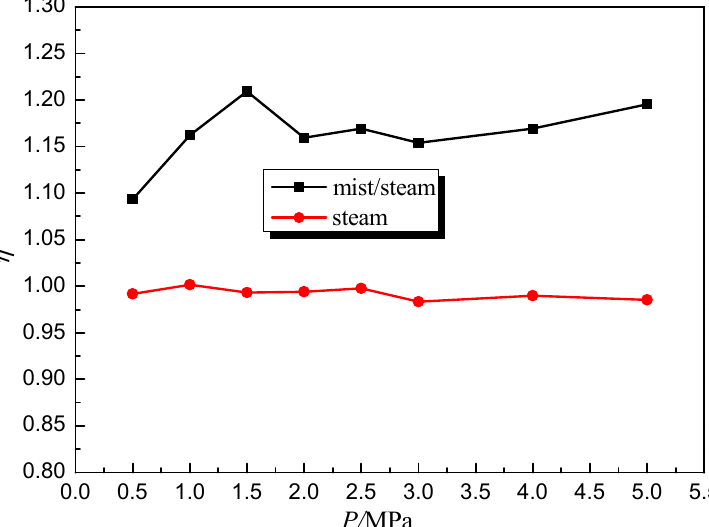
Figure 13. Variation in the heat transfer performance factor of the mist/steam and steam cooling channels with the operating pressure.